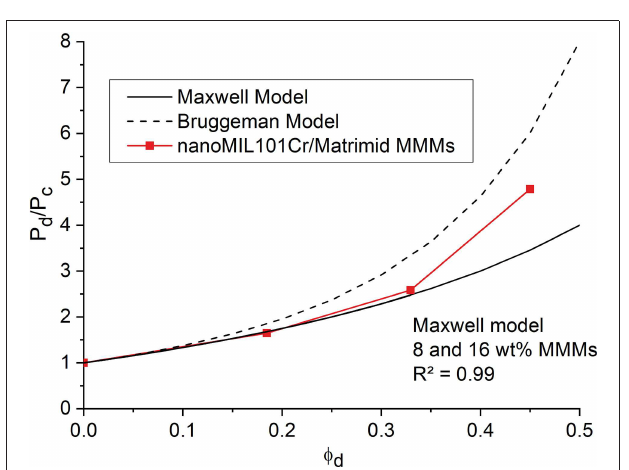
FIGURE 10 | Experimental CO 2 and CH 4 permeabilities of nano- and microMIL-101Cr@Matrimid MMMs as a function of the inverse FFV. The neat polymer has 1/FFV = 5.9, the 20 wt.% microMIL-MMMs has 1/FFV = 3.1, the 24 wt.% nanoMIL-MMM has 1/FFV = 2.8. The added straight lines are intended as guides to the eye.